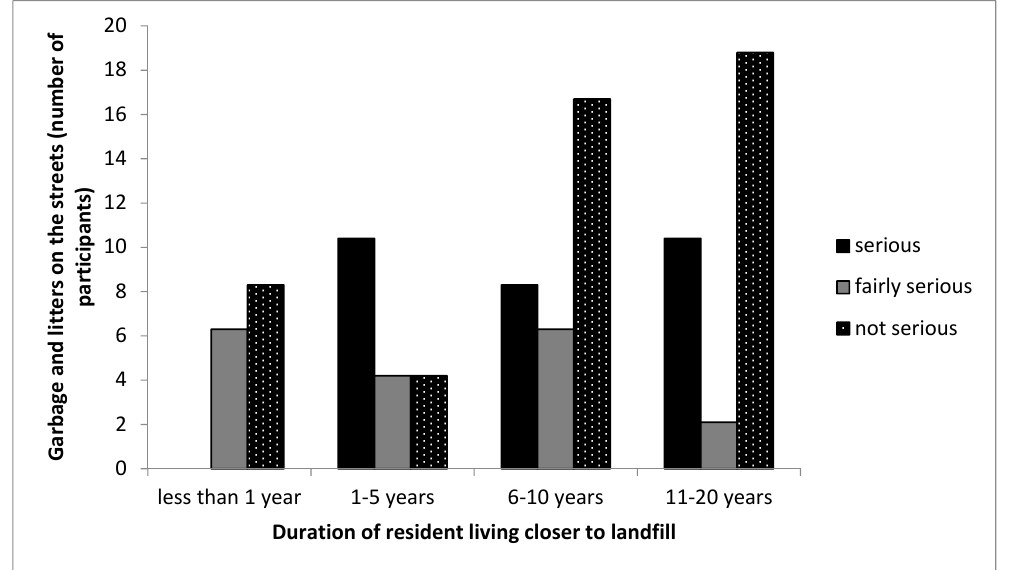
Figure 3. Cross-tabulation between the duration participants lived in the CL community and the seriousness of garbage and litter on the street. Note that the no bar section in the figure indicates there was no response by the participant.